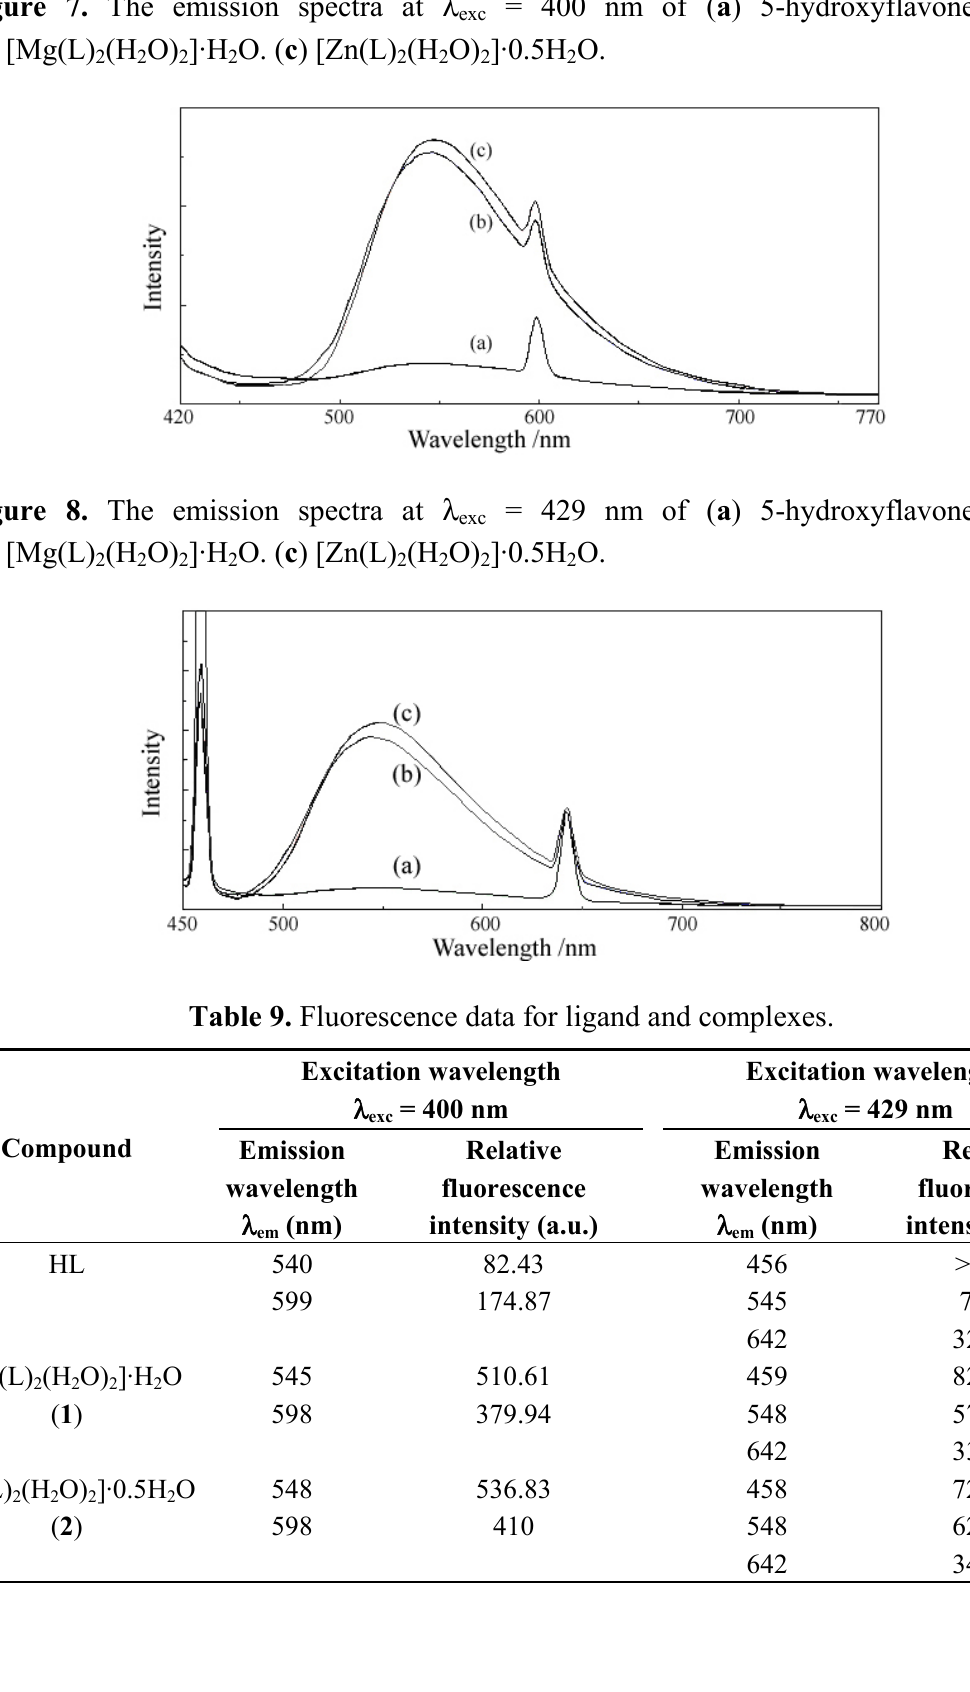
Figure 7. The emission spectra at λ